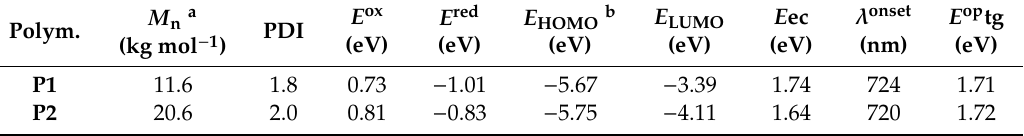
Table 1. Summary of the Photophysical, Electrochemical, and Thermal Properties of P1 and P2 . M n Polym.